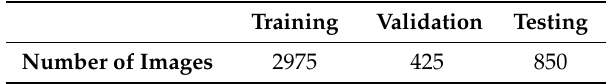
Table 2. Size of training, validation, and testing